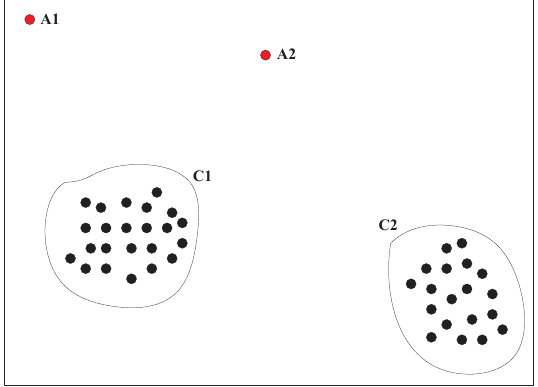
Figure 6. Example of anomaly based on assumption 1